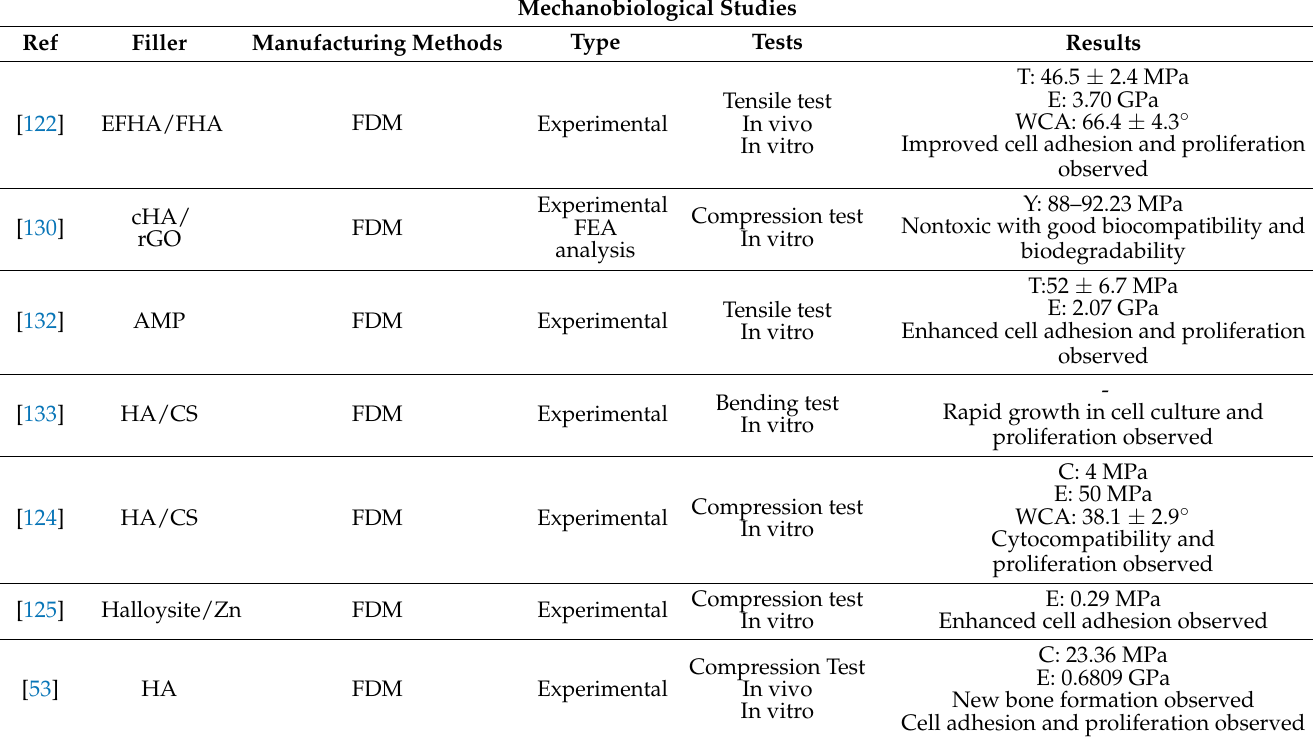
Table 3. Cont. Mechanobiological